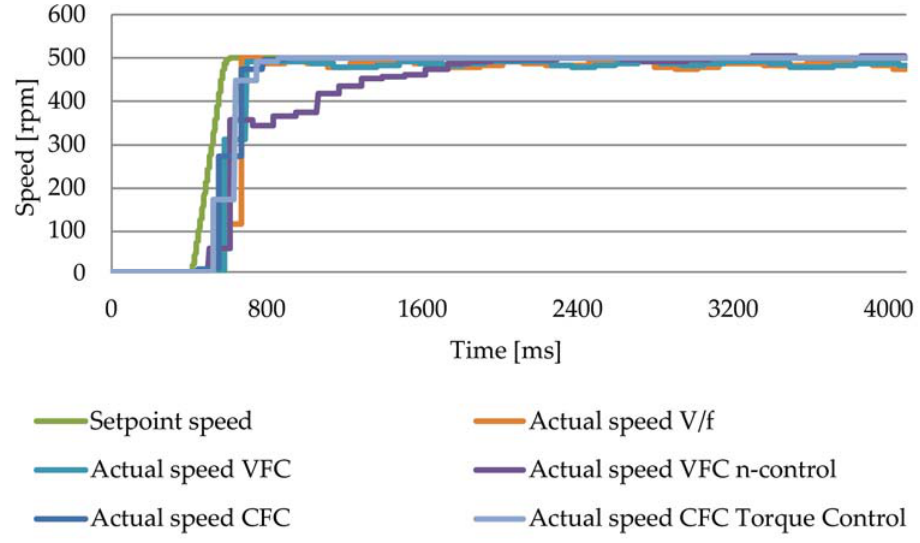
The comparison of the rotational speed (n A ) for various control modes is presented